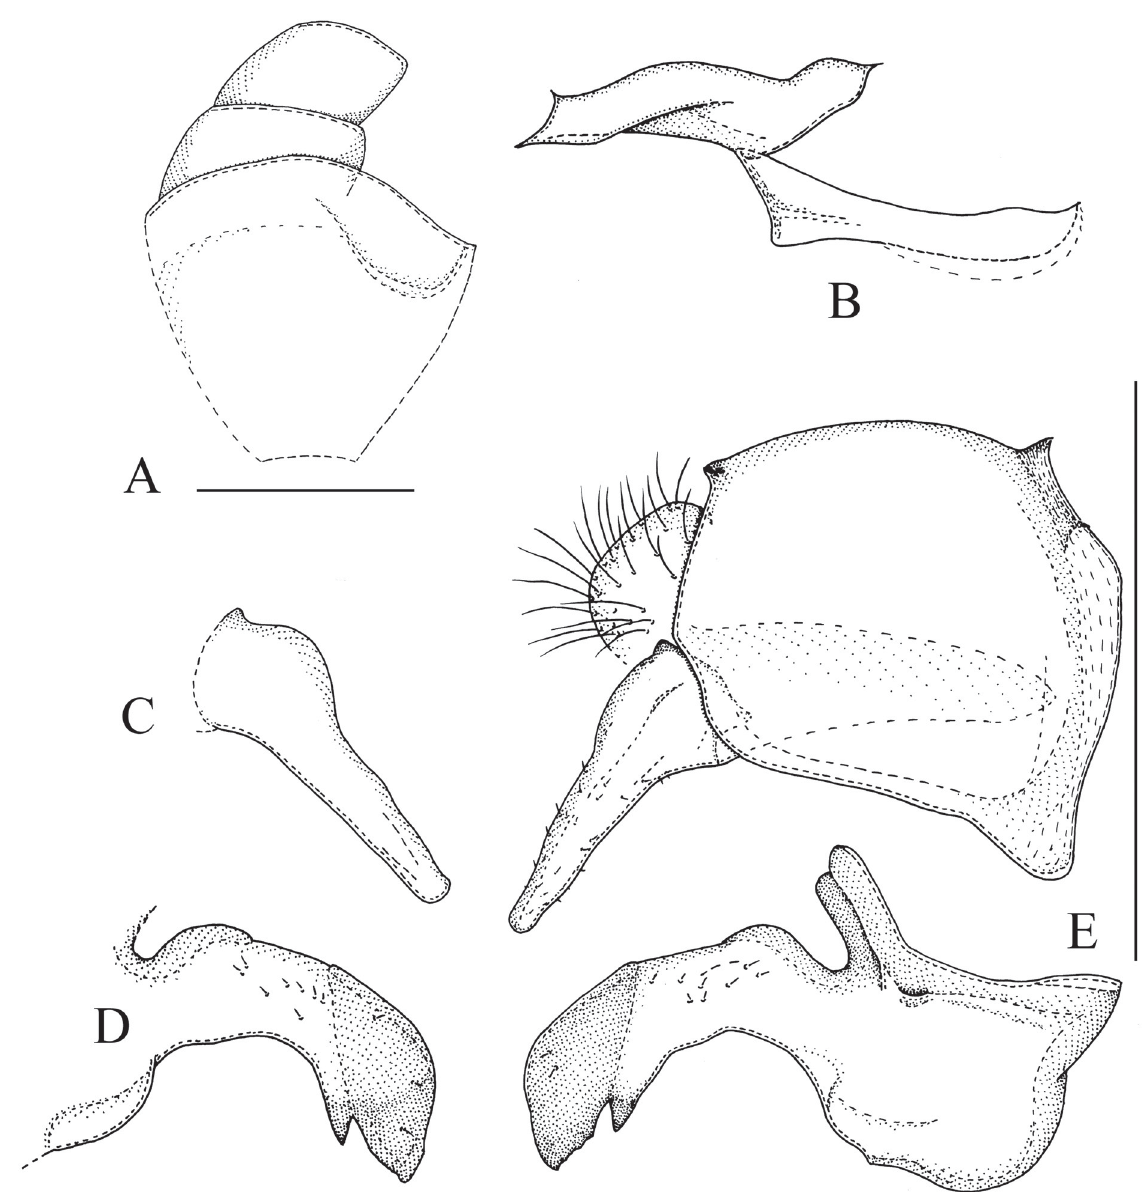
Fig. 5. Sphegi na (Sphegina) guptai Mutin, 1998, holotype, ♂ . A . Sterna IV, VI and VII, ventral view. B . Aedeagus, right side, lateral view. C . Left surstylus, lateral view. D . Left superior lobe, lateral view. E . Genitalia, right side, lateral view. Scale bars = 0.5